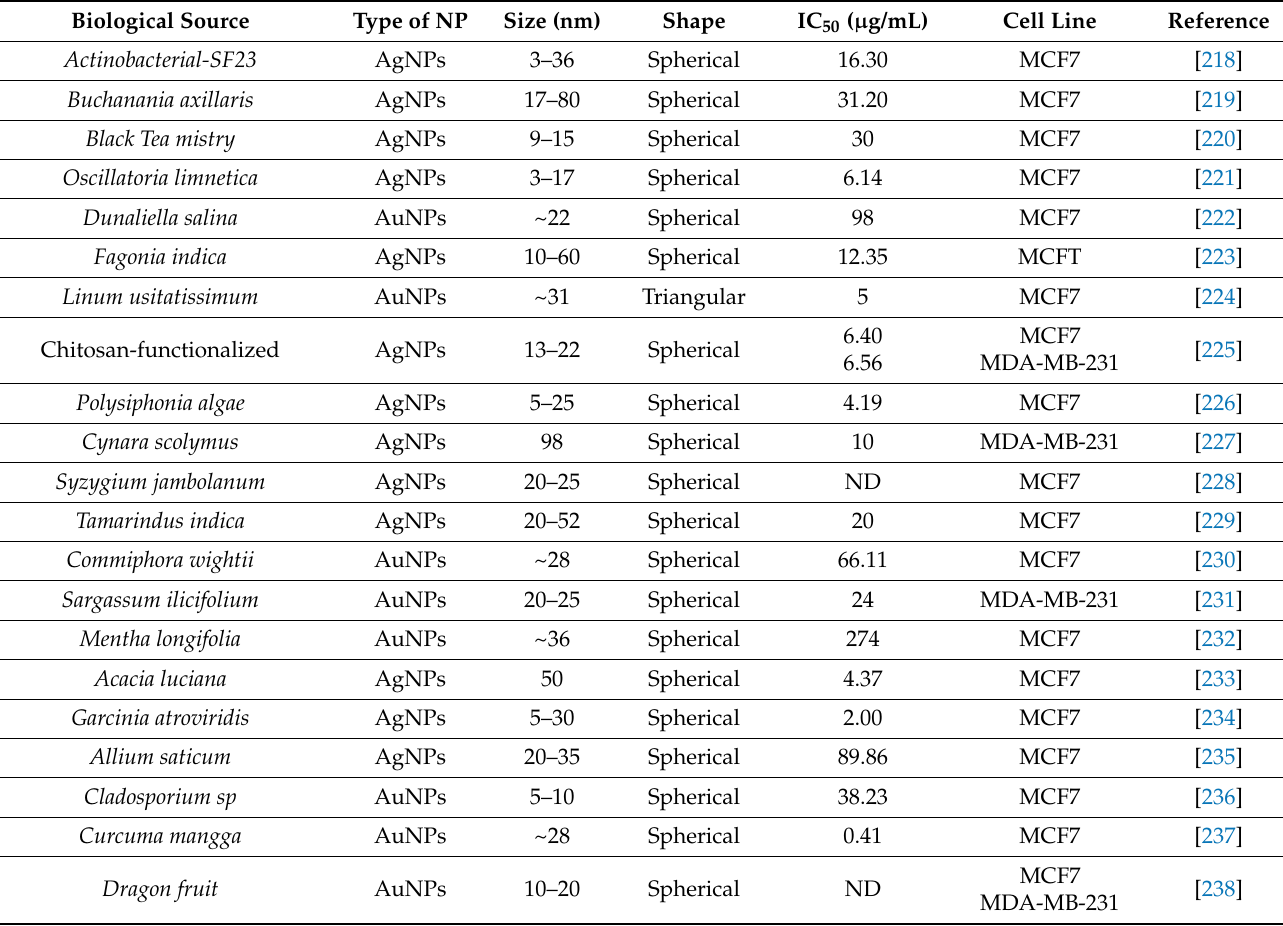
Table 6. Evaluation of green biogenic Au and AgNPs in breast cancer cells; biological source, NPs characteristics, IC 50 , and cell